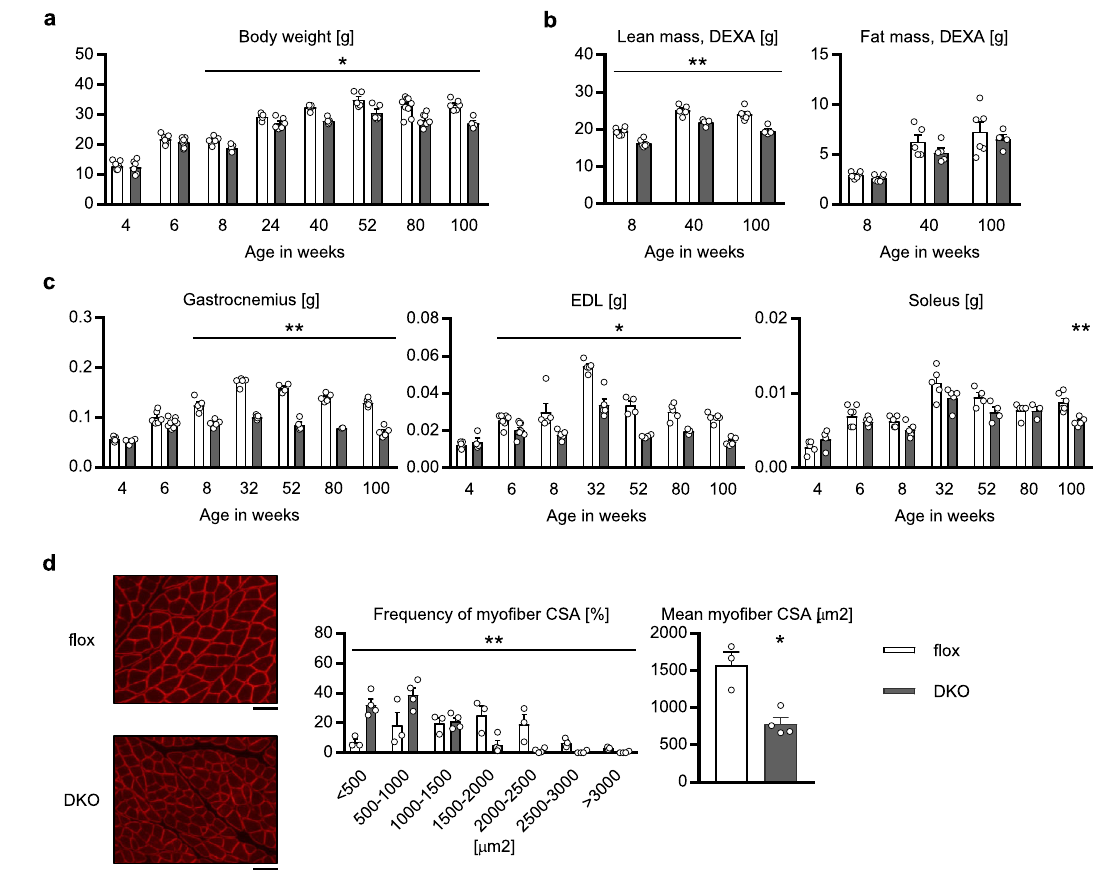
Fig.2|BodyandmuscleweightofthemAktDKOmice.a Bodyweight( n =4,5,6, 7,8or9micepergroup,asshownbythenumberofdatapointsonthegraph,same asbelow)attheageoftheindicatedweeks. b Leanbodymassandfatmassanalyzed by dualenergy X-ray absorptiometry (DEXA) at the age of the indicated weeks ( n =4, 5, or 6 mice). c Skeletal muscle weight at the age of the indicated weeks ( n =3,4,5,6,7,or8mice). d ImmunostainingofEDLwithanti-dystrophinantibody